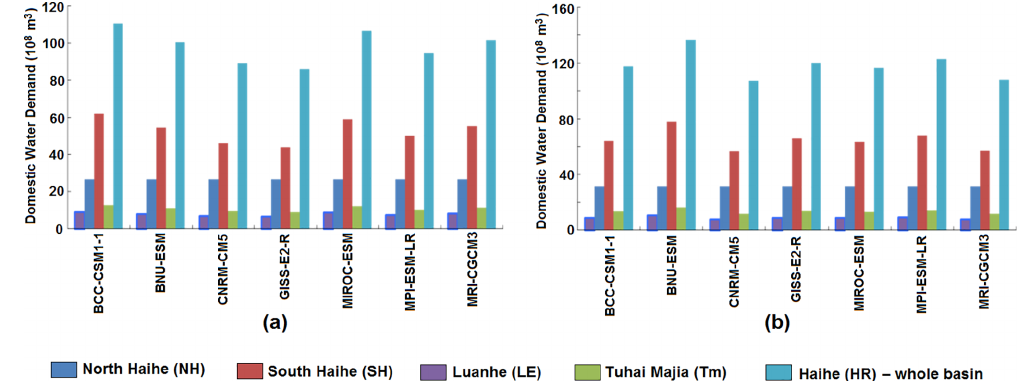
Figure 3. Projection of domestic water demand in different sub-basins of the Haihe River in years (a) 2020; and (b)